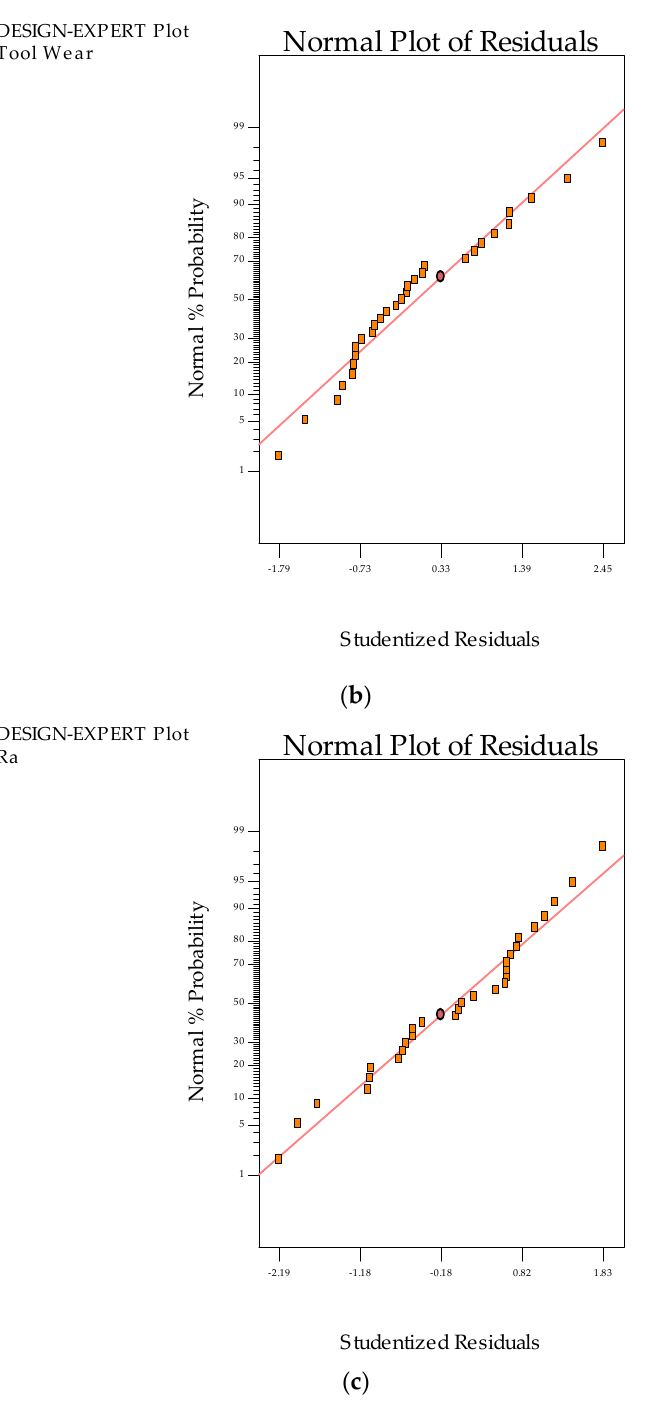
Figure 3. Normal distribution plots. ( a ) Cutting forces; ( b ) Tool wear; ( c ) Surface roughness.